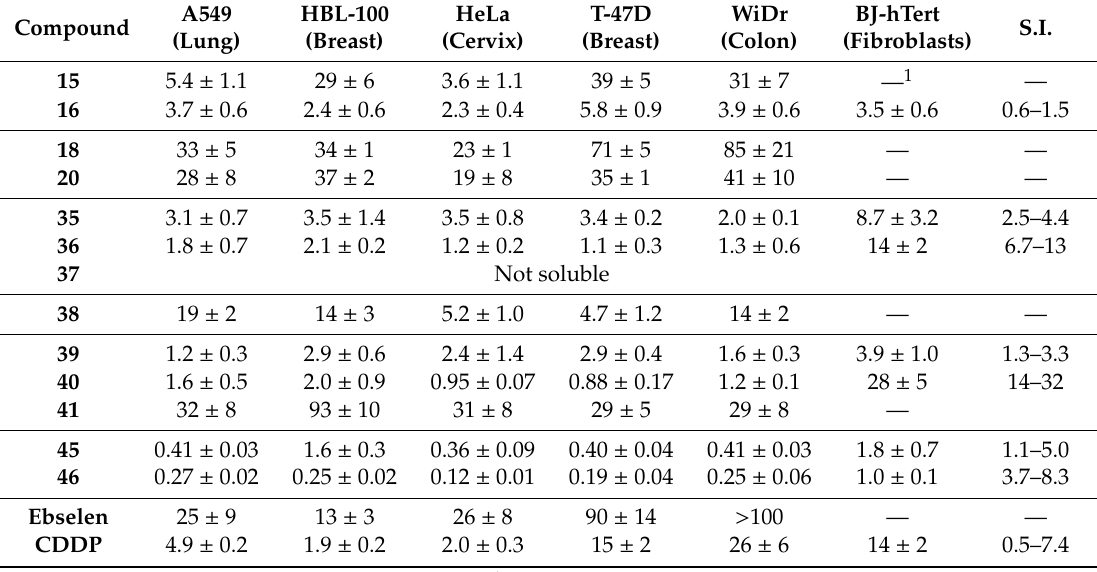
Table 3. Selected GI 50 values ( µ M) for the antiproliferative activity of organochalcogen derivatives.